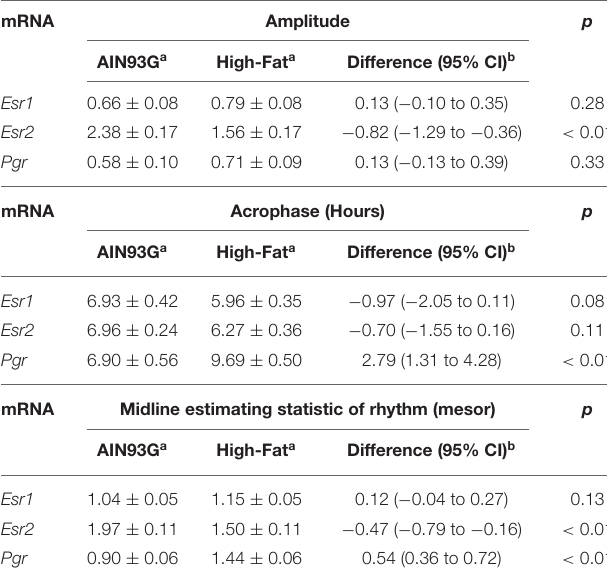
TABLE 3 | Estimated values obtained from the Cosinor model of fold changes in the expression of genes encoding estrogen receptors and progesterone receptor in mammary glands from pubertal mice fed AIN93G or high-fat diet.